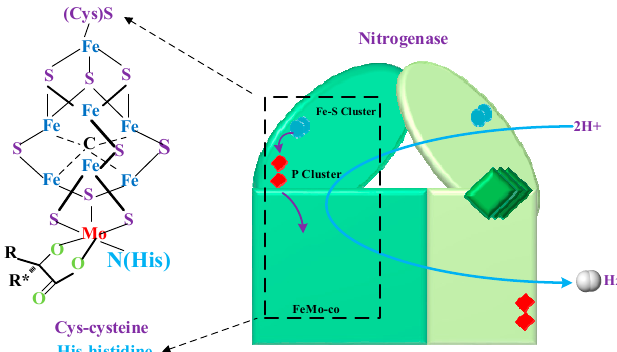
Figure 1. Schematic structure of nitrogenase, where R and R* are the ligands. The figure was rearranged from Seefeldt et al. [23].